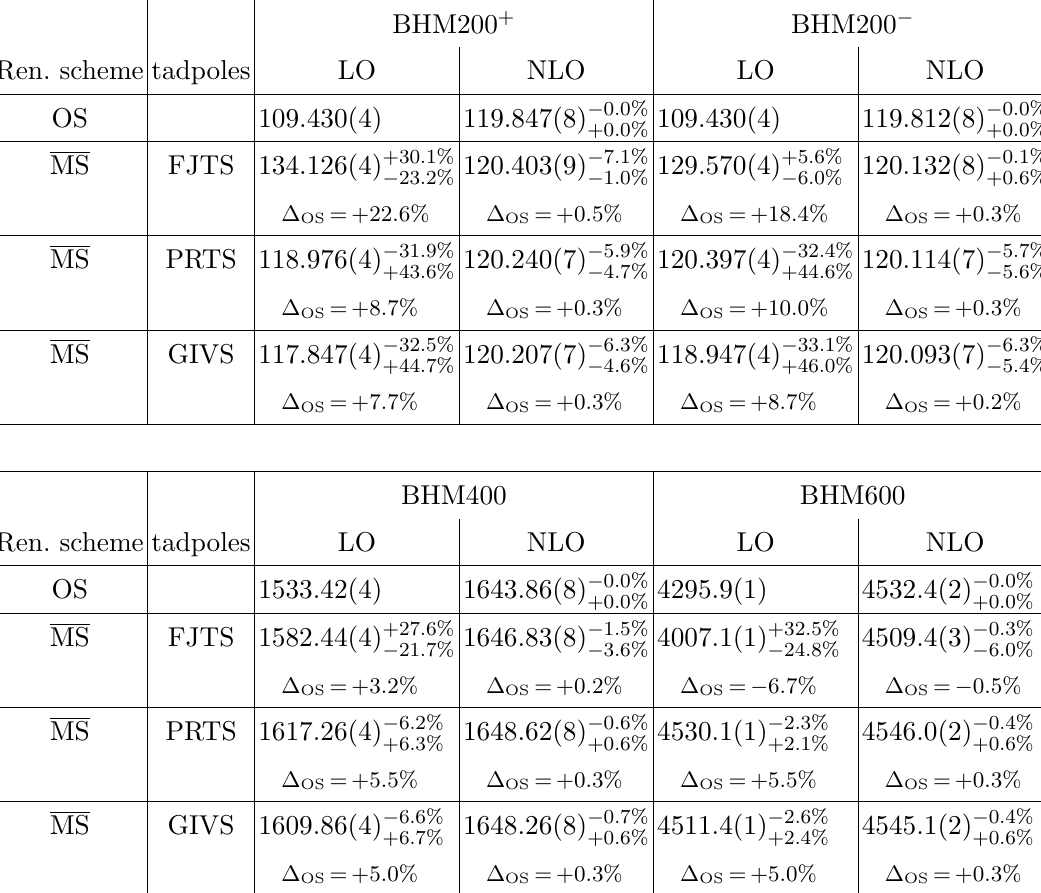
Table 2 . As in table 1, but for the decay width Γ H → 4 f [MeV] of the heavy SESM Higgs boson